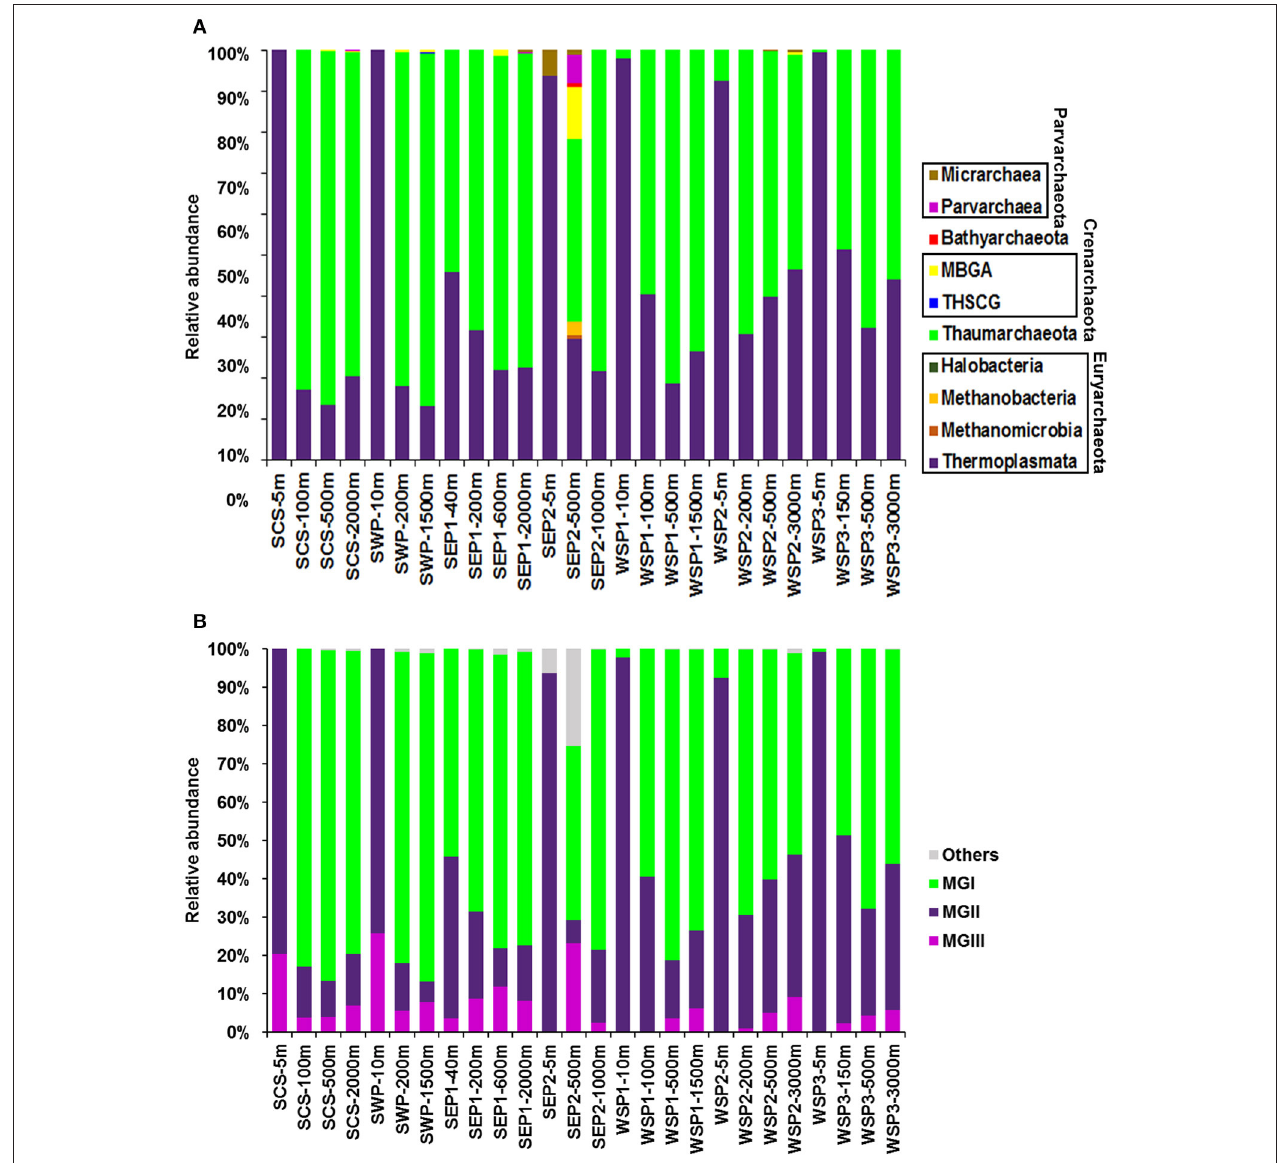
FIGURE 3 | The relative abundance of the archaeal taxonomic groups in each sample. (A) Sequences were identified at the phylum level based on the Greengene database. (B) The relative abundance of each phylogenetic